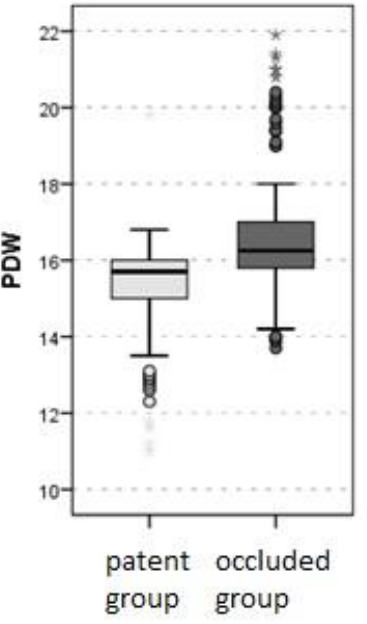
Fig. 2 – Box-plot diagram of platelet distribution width (PDW) by group.